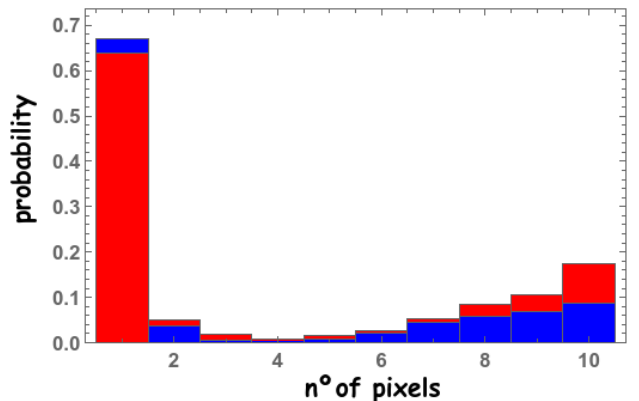
Figure 9. Simulated probability of detecting the first 10 fast photons in up to 10 different pixels for 3 × 3 mm 2 (blue) and 1 × 1 mm 2 (red) pixels.